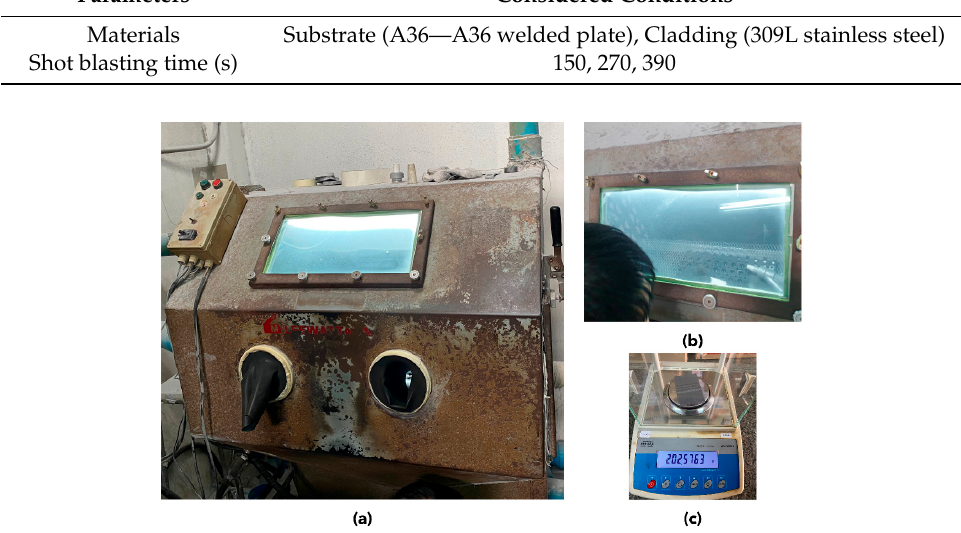
Table 7. The considered conditions in the shot blasting tests.